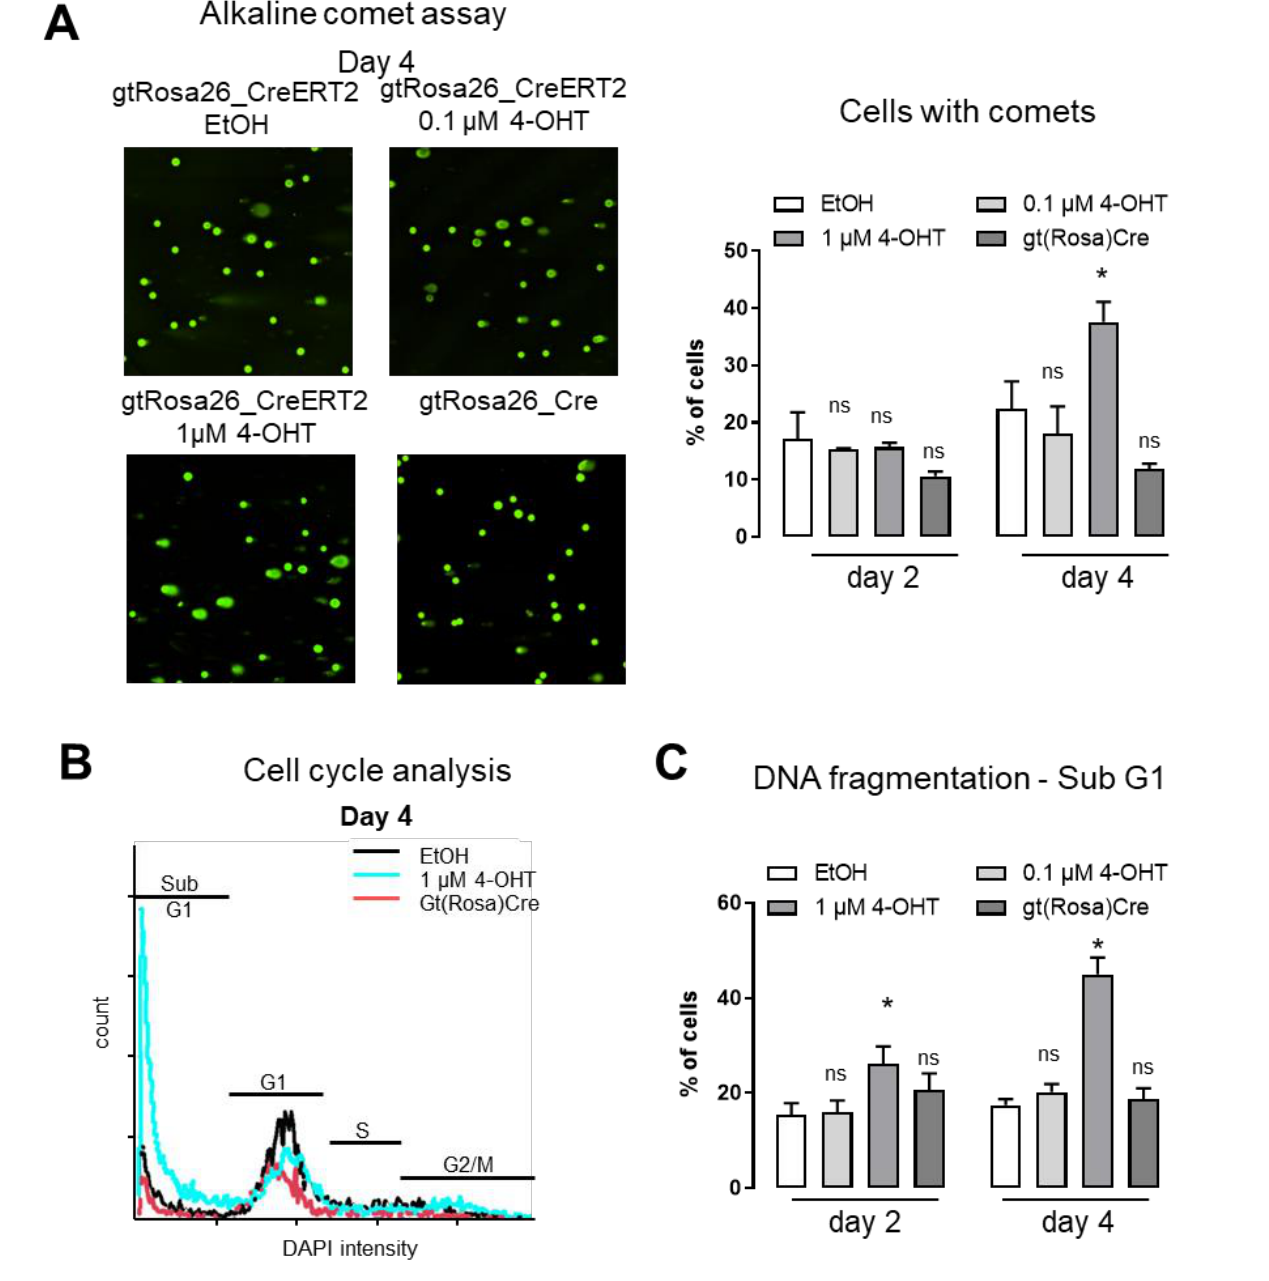
Figure 4. Acute activation of Cre-recombinase forces DNA damage ( A ) Alkaline Comet Assay stained with SYBR Gold. Left panel representative images. Percentage of cells with comets. * p < 0.05, n = 3–6; mean with SEM. 2-way Anova. ( B ) Representative raw data plot of DNA fragmentation and cell cycle analysis of DAPI stained cells using the Nucleocounter NC-3000 treated with 4-OHT as indicated. Cells were analyzed at day 4. Cells with fragmented DNA are in SubG1 phase. ( C ) Percentage of cells with fragmented DNA was analyzed. n = 6; mean with SEM; ns: none significant and * p < 0.05 EtOH vs. 4-OHT or gtRosaCre as indicated; 2-way Anova.